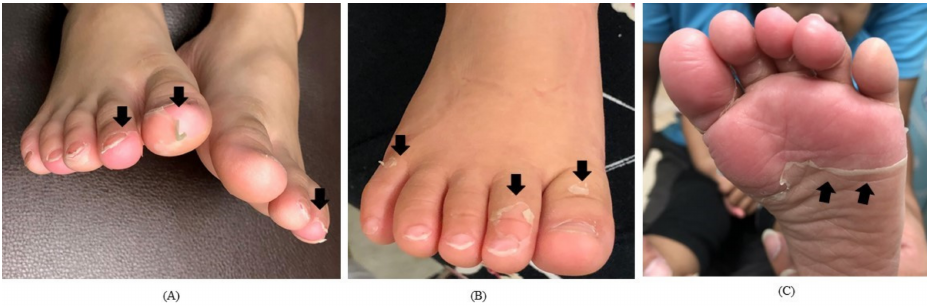
Figure 3. The desquamation of feet; the black arrows point out the margin of peeling; ( A ): grade 1; ( B ): grade 2; ( C ): grade